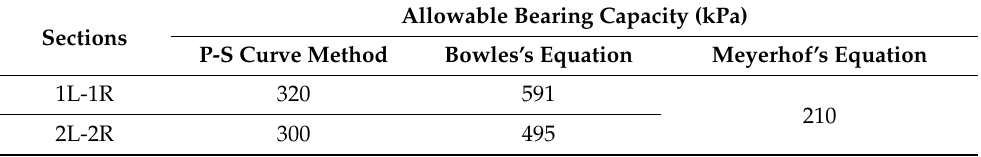
Table 7. Bearing capacities by various